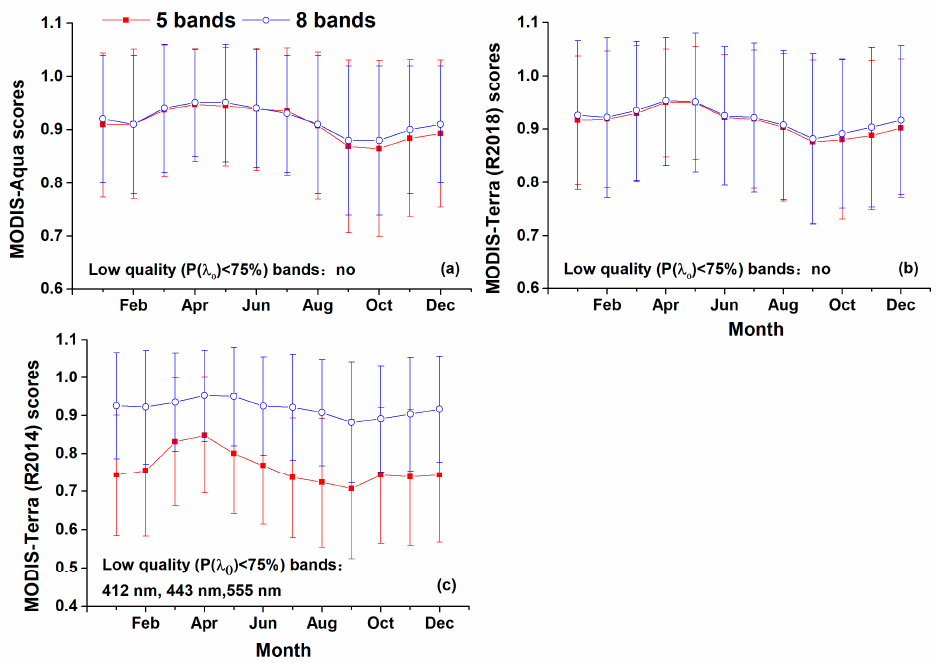
Figure 12. Comparison between R rs ( λ ) QA scores based on 5-band (red) and 8-band (purple) for MODIS-Aqua ( a ), MODIS-Terra (2018) ( b ), and MODIS-Terra (2014) ( c ).